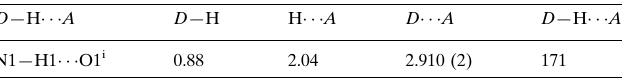
Hydrogen-bond geometry (A˚ , (cid:1)